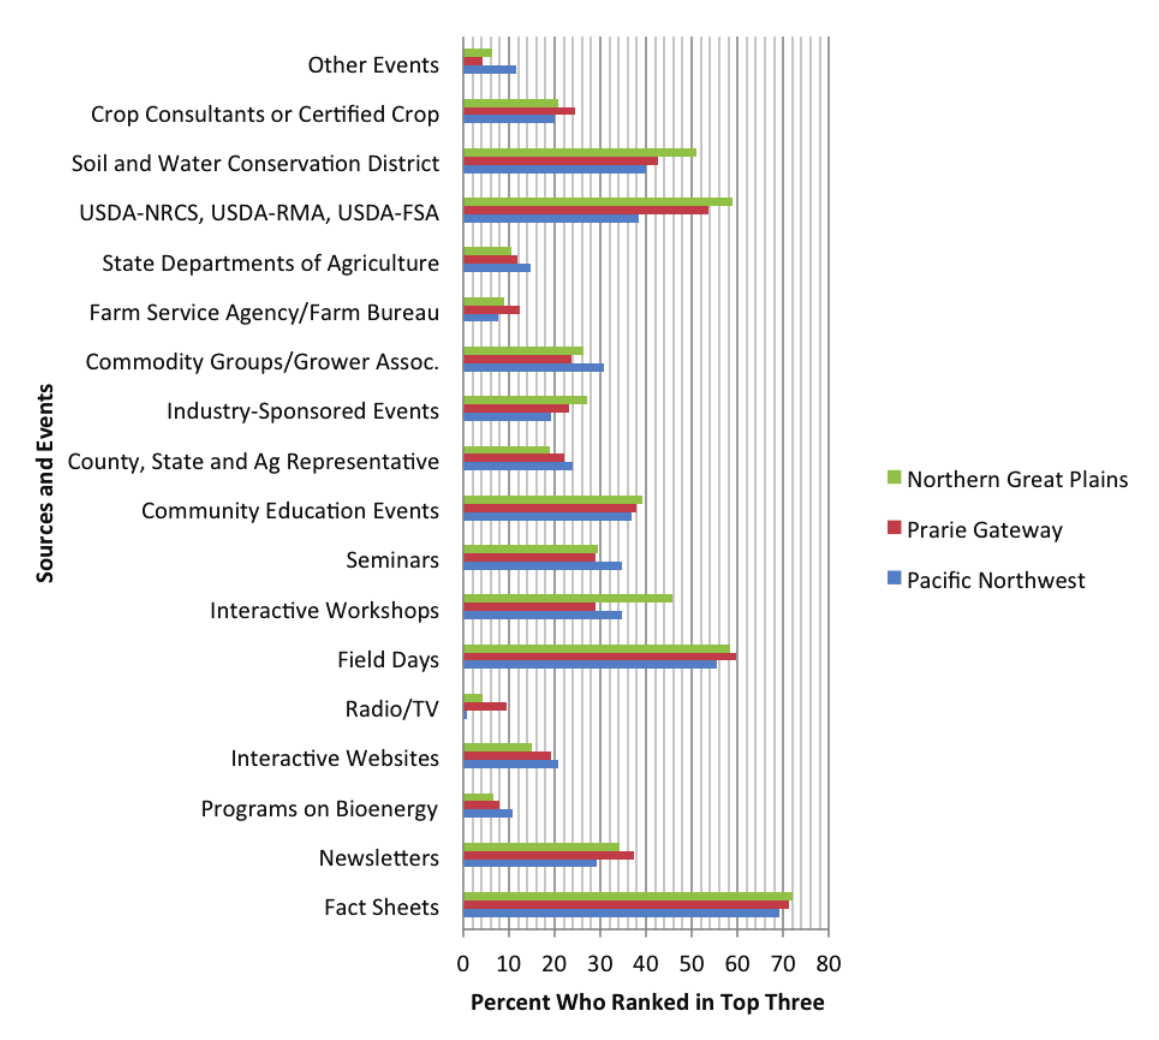
Figure 4: Sources and events that extension educators and other outreach personnel ranked in the top three types they would likely use the most to provide crop related information to farmers. (Sample size for each region is: Pacific Northwest N = 130; Prairie Gateway N = 433; and Northern Great Plains N =